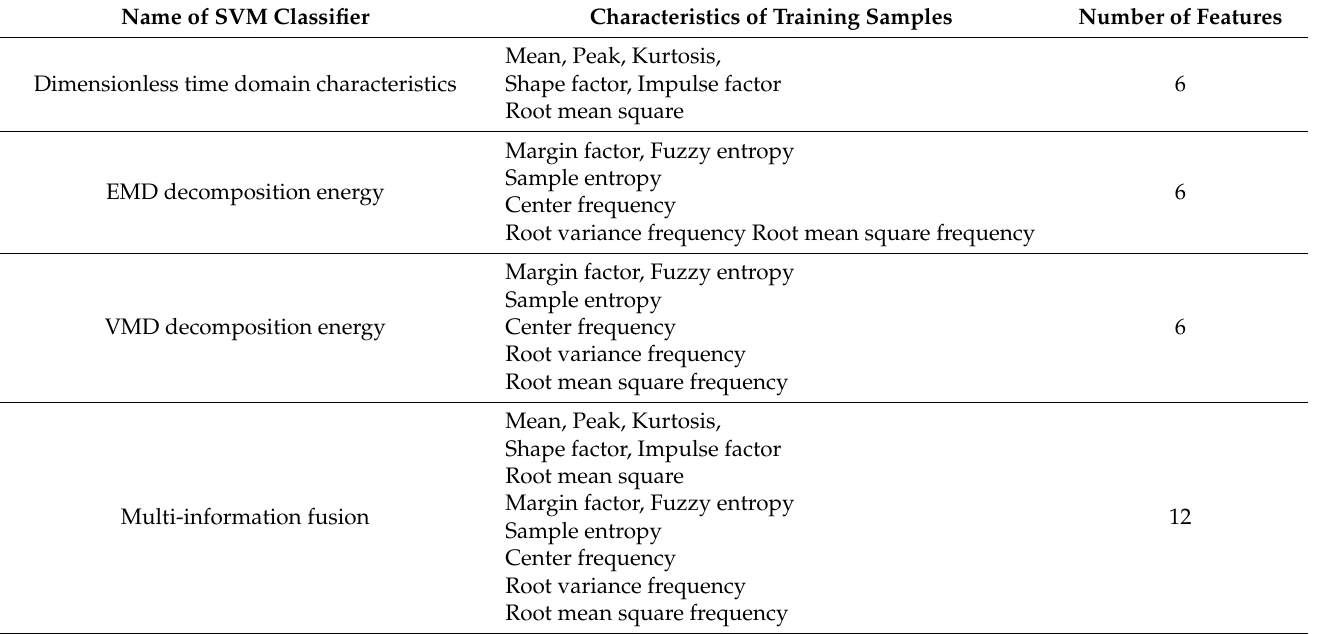
Table 4. Four different types of SVM classifiers.